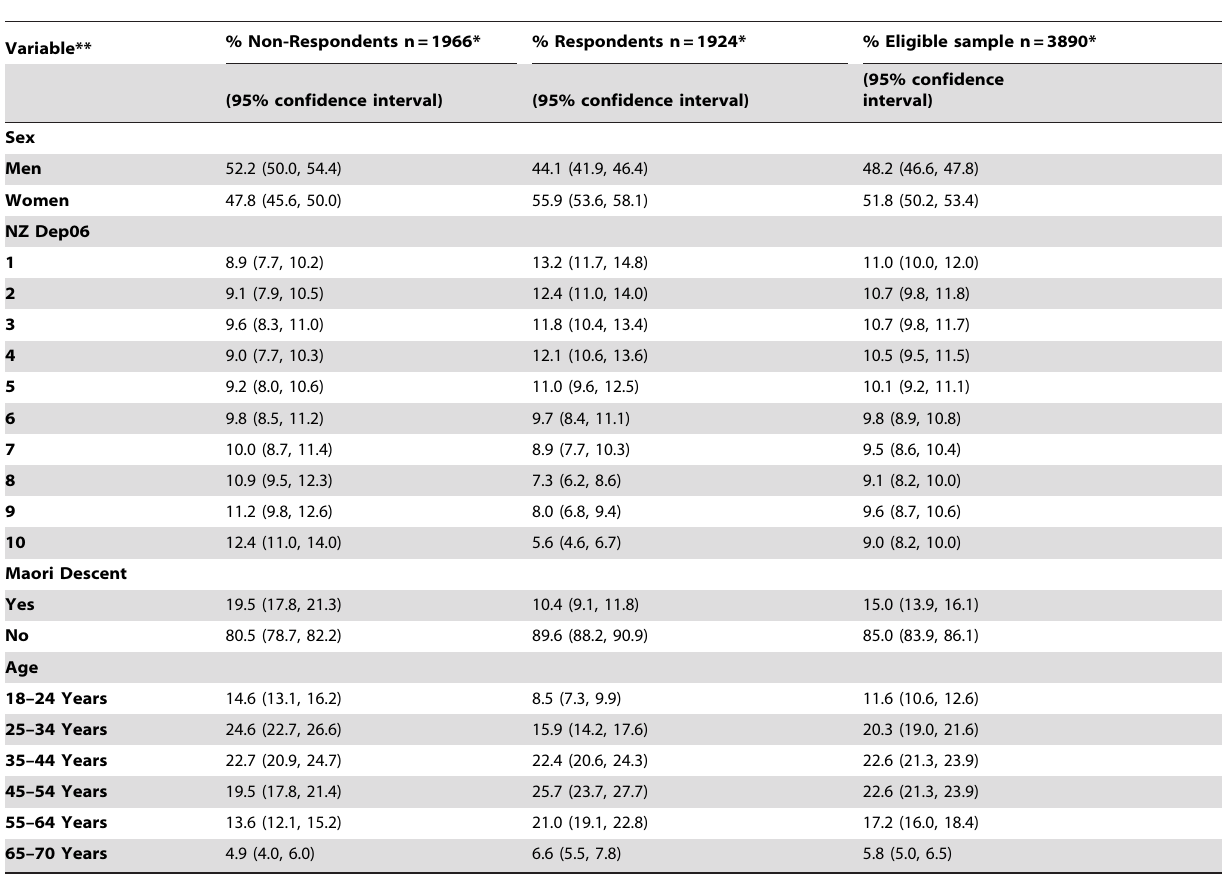
Table 1. Demographic distribution in non-respondents, respondents and total eligible sample.